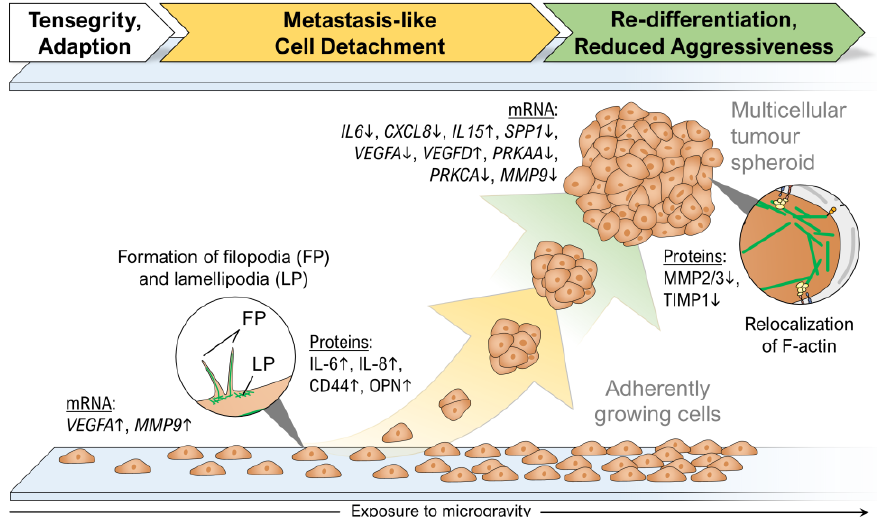
Figure 8. From metastasis-like cell detachment to lower aggressiveness: the transformation of thyroid cancer cells during their exposure to microgravity. The green lines show F-actin filaments. ↓ down-regulation / decrease, ↑ up-regulation /